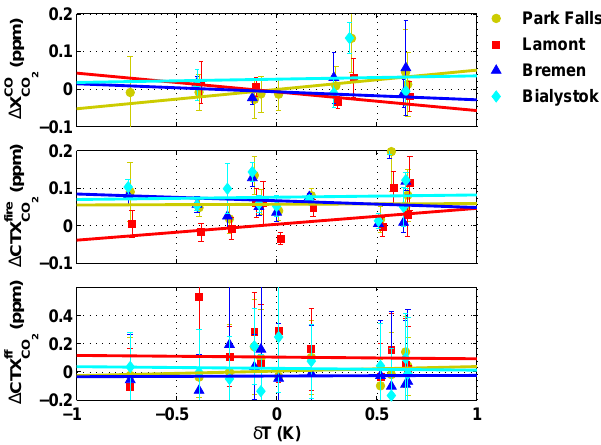
calculated from Fig. 8. The top panel shows the TCCON 1 X CO 2 measured 1 X CO during the summertime drawdown against the respiration-weighted surface temperature, to probe the effects of forest fires on the 1 X CO . The solid lines show the best-fit lines, 2 which have very poor fit statistics ( R 2 < 0 . 2). The middle panel shows the CT2011 fire contribution to the summertime drawdown in CTX CO , which also has a negligible relationship with the 2 respiration-weighted surface temperature. The bottom panel shows the CT2011 fossil fuel contribution to the summertime drawdown, which has a negligible relationship with the respiration-weighted surface